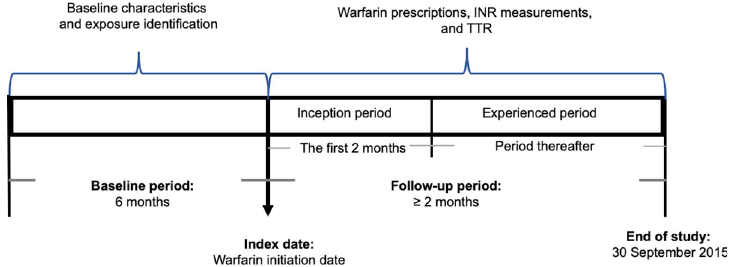
Fig 1. Schematic diagram for the study design. Note: INR: International Normalized Ratio, TTR: Time to Therapeutic Range.